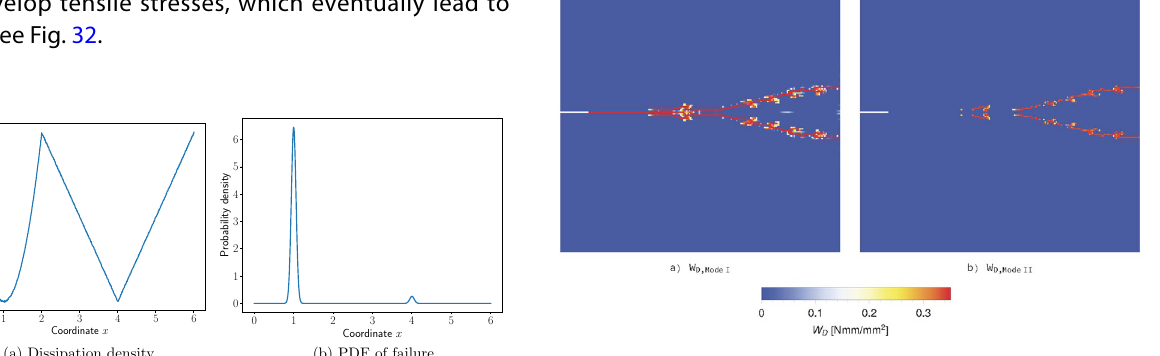
Fig. 31 Bar with linearly and quadratically varying fracture energy